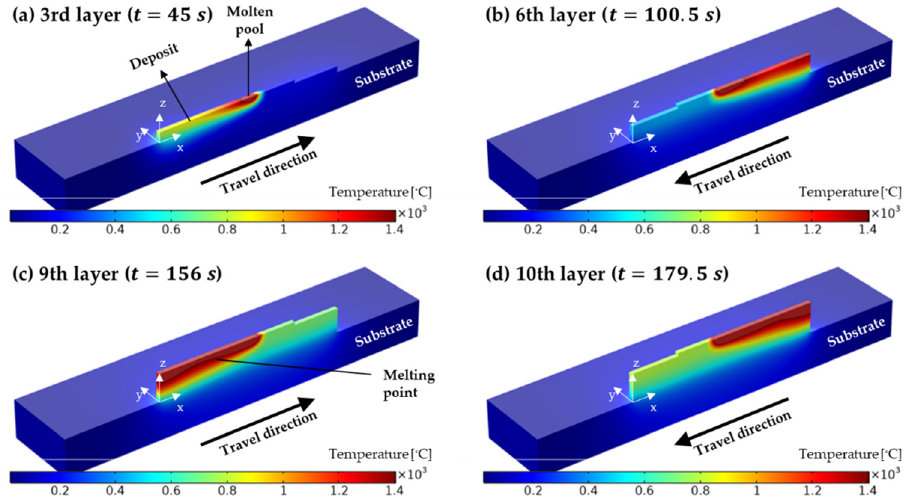
Figure 2. The temperature distribution of the deposit during the process of different layers in the simulation of the WAAM process; ( a ) 3rd layer; ( b ) 6th layer; ( c ) 9th layer; ( d ) 10th layer.